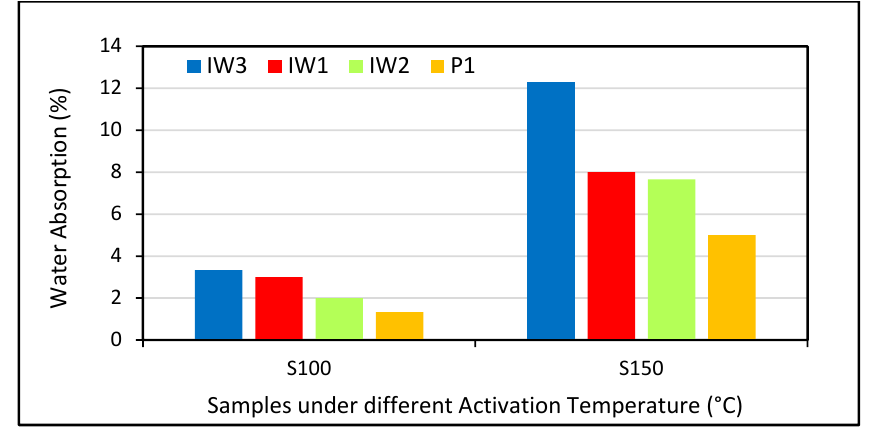
Figure 16. Water absorption (WA) for various materials at different activation temperatures (°C) [248].